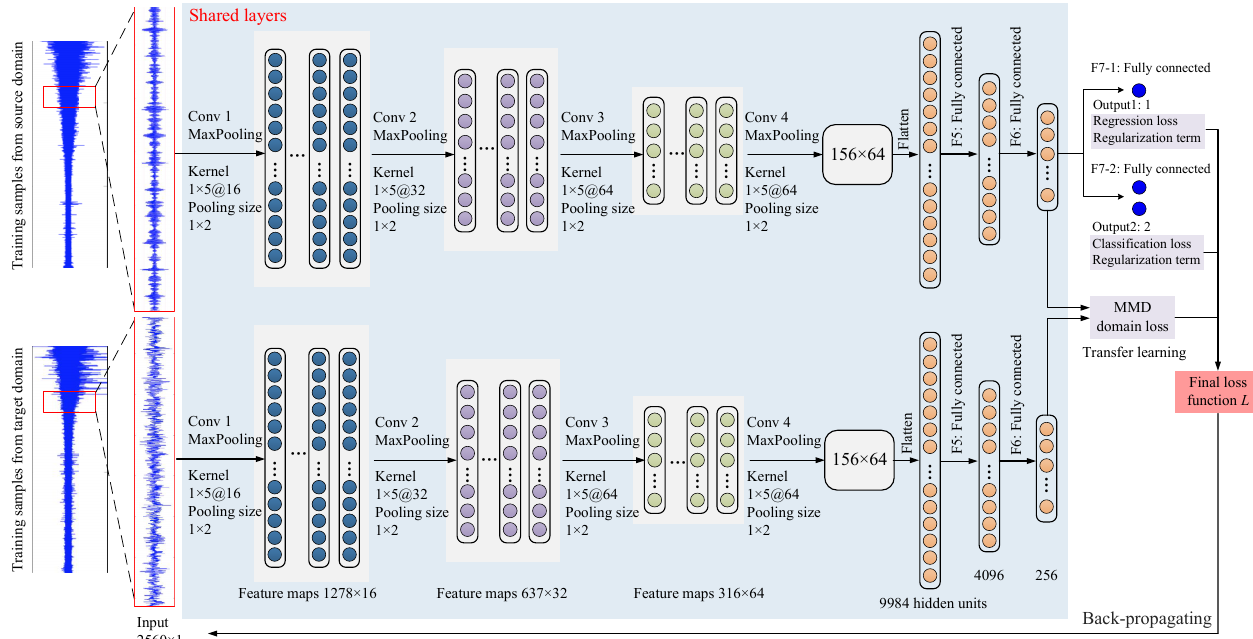
Figure 3. Architecture of the proposed TR